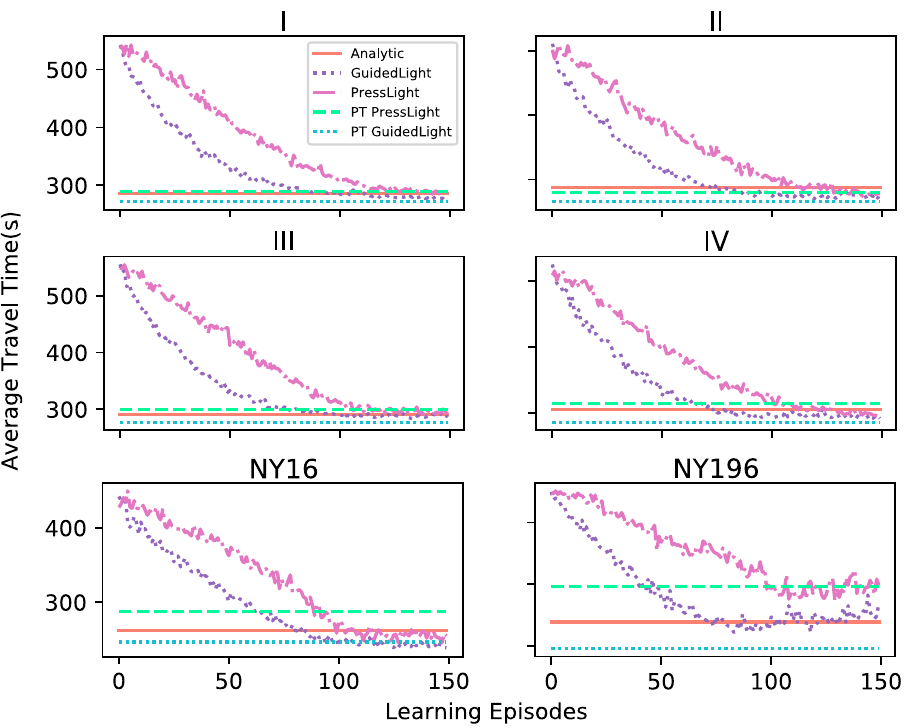
Figure 5. Average travel time achieved through learning epochs for PressLight and GuidedLight along with the results achieved by the non-trained methods: analytic and two pretrained (PT)